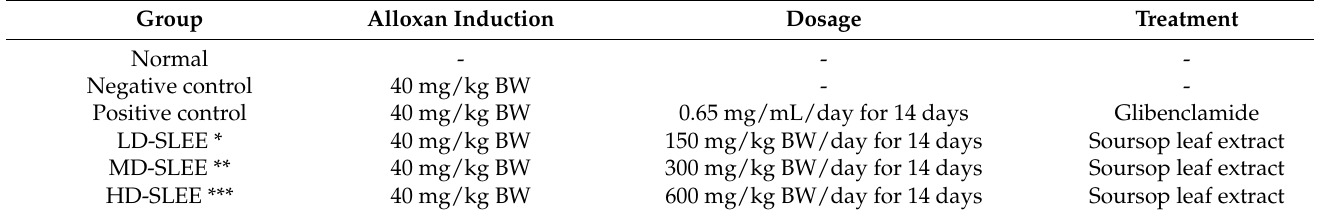
Table 1. Mice groups were treated in determining potential antidiabetic agents and